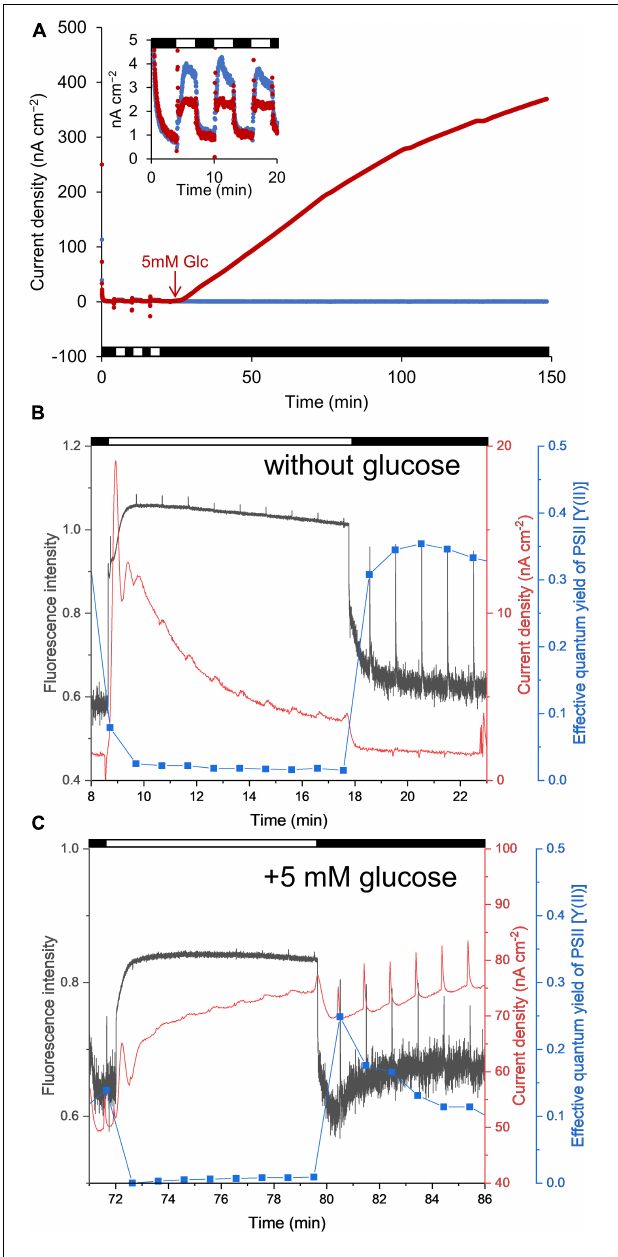
FIGURE 2 | (A) Time courses of anodic current generation from S6803 cells at + 0.25 V vs. Ag/AgCl. Red and blue lines indicate the current with and without 5 mM glucose, respectively, added at the point indicated by the red arrow. The inset shows an enlarged view of the data up to 20 min. (B,C) Chlorophyll fluorescence (black lines), current (red lines) and effective quantum yield of the PSII complex [Y(II)] (blue lines) as functions of time with and without glucose. The spikes observed at every 1 min resulted from saturation pulses. The horizontal white and black bars in each graph indicate light [ (A)